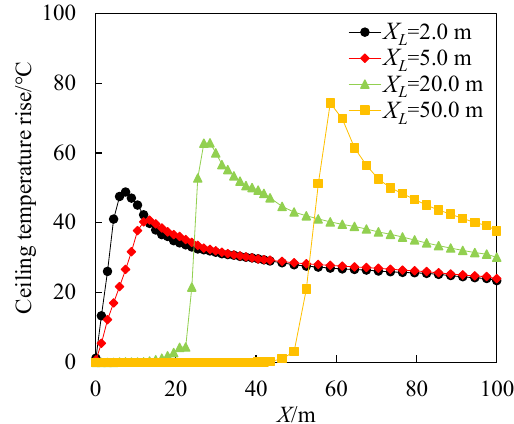
Figure 8. The ceiling temperature rise of longitudinal smoke in the tunnel. Figure 8. Longitudinal ceiling temperature rise under different fire